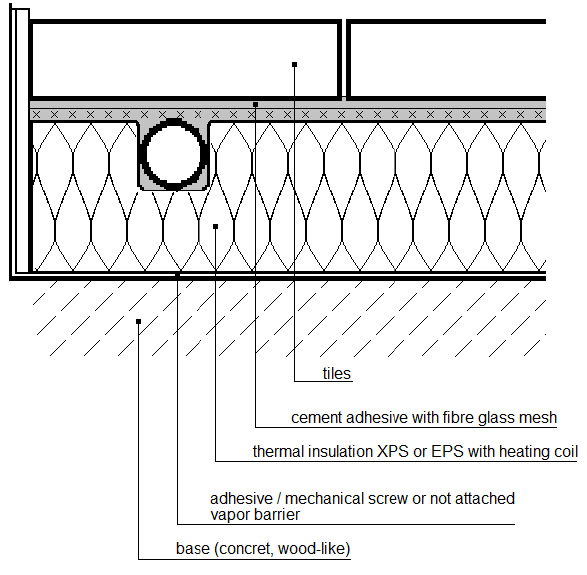
Figure 1: Cross section of layers in LFS with a heating coil